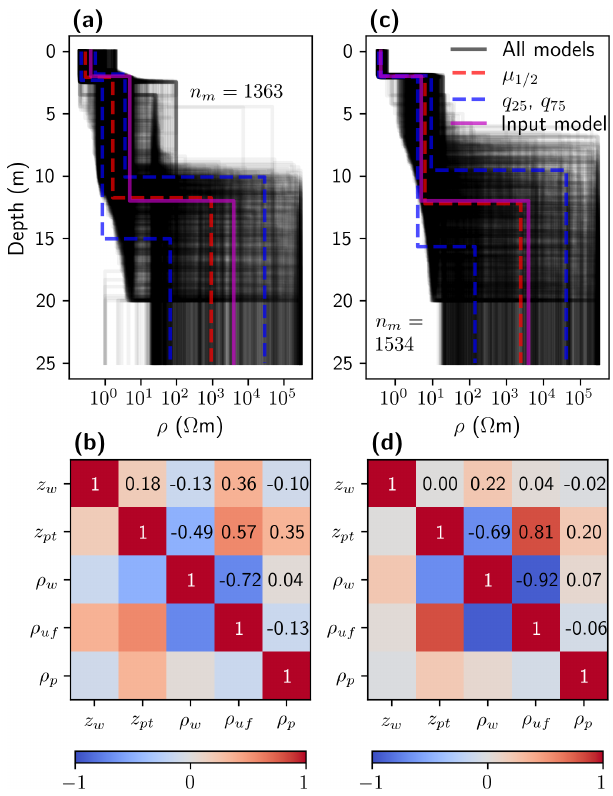
Figure 9. One-dimensional inversion results of synthetic data for 1D subsurface scenarios developed for the Drew Point field site. (a) Ensemble with n m model solutions and (b) the corresponding symmetric correlation matrix for scenario 1 (water layer parameters with large freedom during inversion) and (c–d) the same for sce- nario 2 (with constrained z w , ρ w , and ρ uf ). Black lines in panels (a) and (c) are plotted with transparency, and, therefore, the darker ar- eas indicate higher densities model. The numbers in panels (b) and (d) are the corresponding correlation